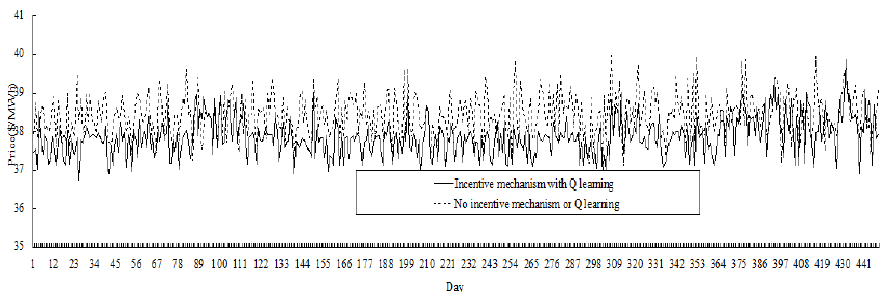
Figure 10. Comparative results of price variation (for 448 days).